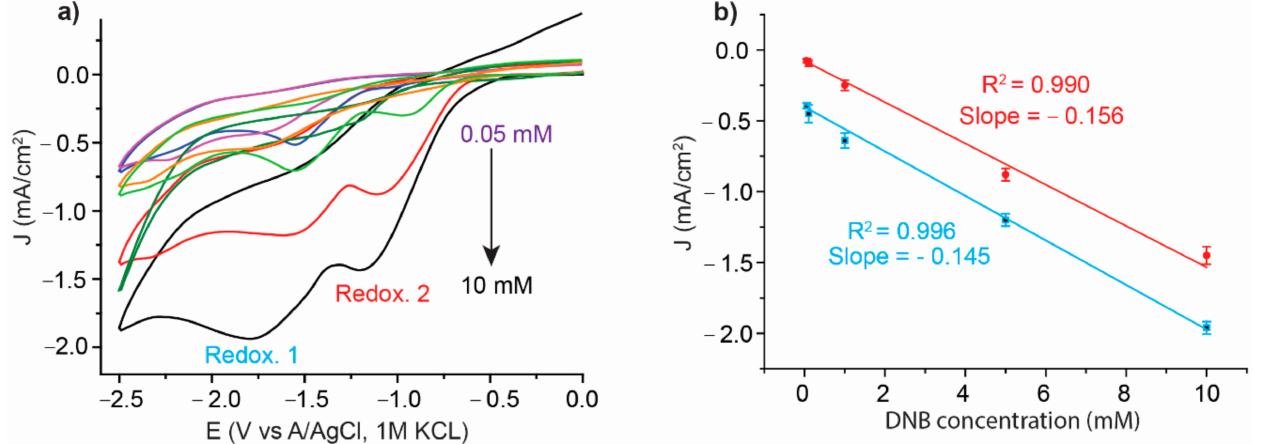
Figure 4. ( a ) CV showing the increase in the reduction peak current of DNB on Si–H between 0.05 mM and 10 mM. ( b ) Calibration curves of DNB on Si–H electrode obtained by plotting the peak current of redox peak 1 (blue) and redox peak 2 (red) against its corresponding